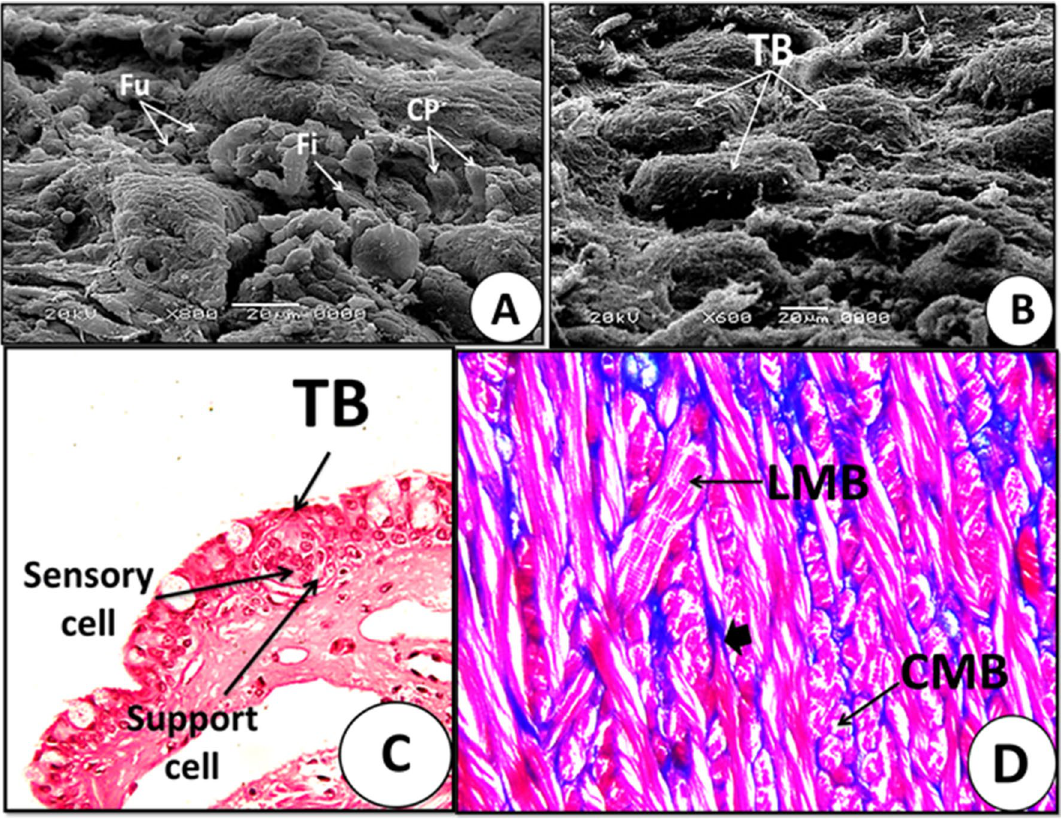
Fig. 3 A A scanning electron micrograph (SEM) of the dorsal surface of the anterior region of the tongue of Hemidactylus turcicus showing fungiform (Fu), filiform (Fi) and cuboid papillae (CP). Scale bar 20 µm, X 8.00; B scanning electron micrograph of the dorsal surface of the anterior region of the tongue of H. turcicus showing taste buds (TB), Scale bar 20 µm, X 6.00; C a photomicrograph of a longitudinal section of the posterior region of the tongue of Hemidactylus turcicus stained with H & E showing taste bud (TB) provided with sensory and support cells, X 400; D a photomicrograph of a longitudinal section of the anterior region of the tongue of Hemidactylus turcicus stained with Mallory’s triple stain showing collagen content appeared in dark blue color (arrow) and surrounds the circular (CMB) and longitudinal muscle bundles (LMB), X